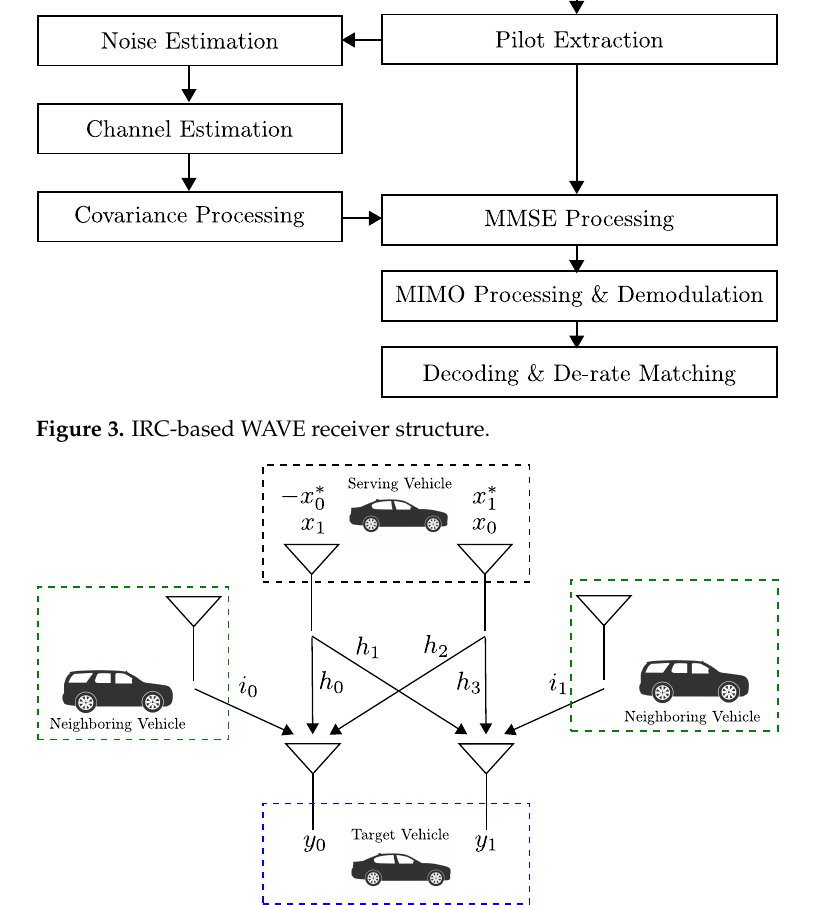
Figure 4. Overall structure of MIMO (2 × 2) system model. Note that the neighboring vehicle on the left and right are identical and the same entity. We described one vehicle as two separate entities on the left and right sides to clarify the interference matters from the neighboring vehicle with a single